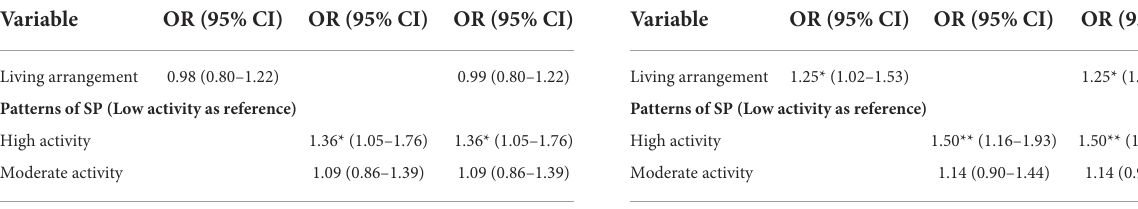
TABLE 4 Logistic regression models between living arrangement, patterns of social participation and positive emotions ( n = 2,537).